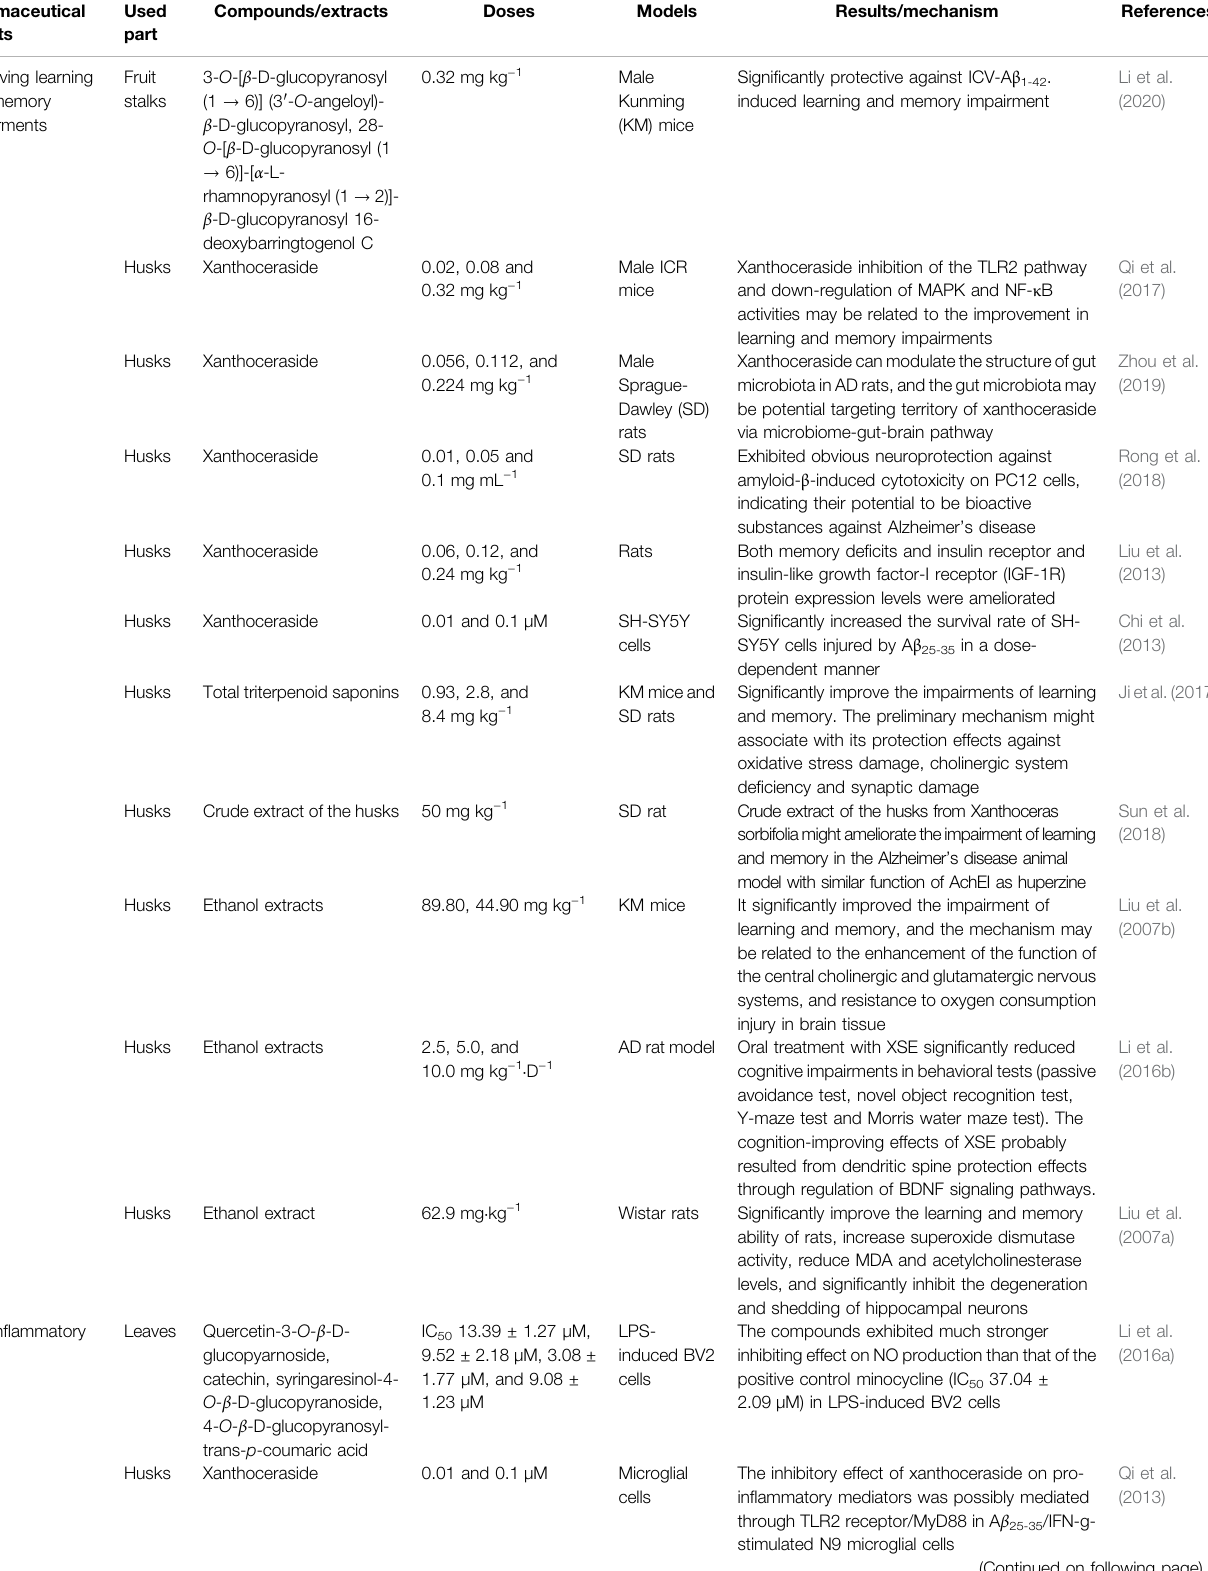
TABLE 2 | The pharmaceutical effects of X.